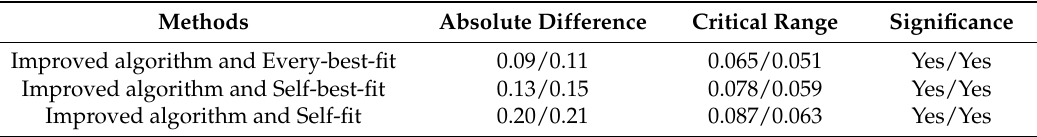
Table 5. The results of the Marascuilo